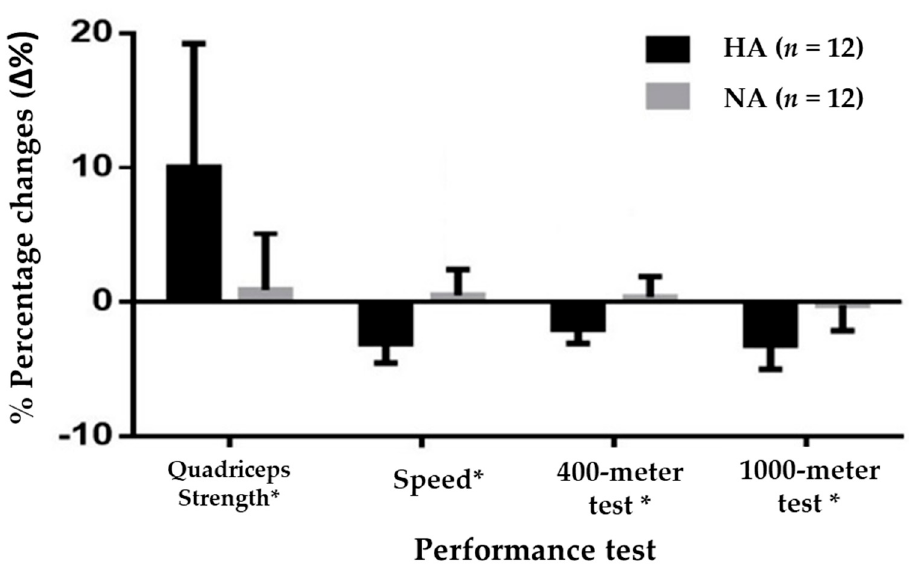
Figure 3. The percentage changes in the performance test results of the two study groups: HA, hypoxic intervention group; NA, control group; % percentage changes ( ∆ %), ((T3 − T1)/T1) × 100; *, significant differences ( p < 0.05) between the groups at specific time points, according to the t -test for independent variables.